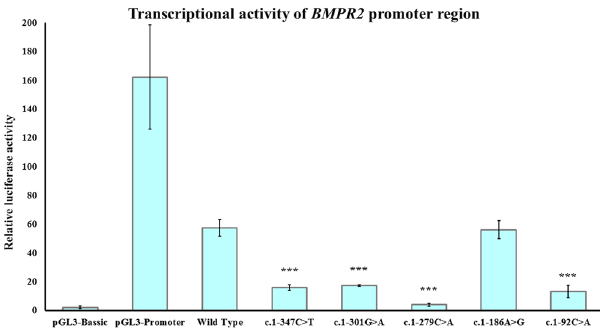
Figure 8. Transcriptional activity of the 5 ′ UTR region of the BMPR2 gene containing different mutations (c.1-347C > T, c.1-301G > A, c.1-279C > A, c.1-186A > T and c.1-92C > A). The pGL3-Basic vector